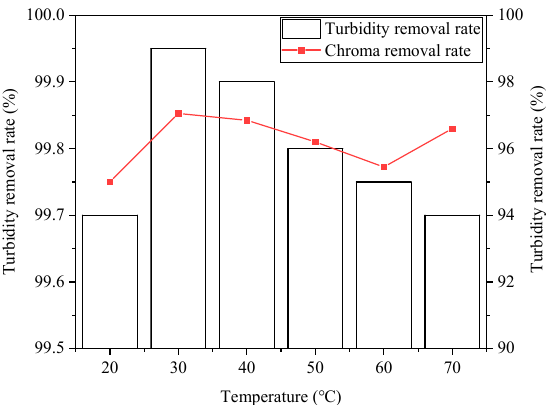
Figure 11. Effect of temperature on removal rates of turbidity and chroma.